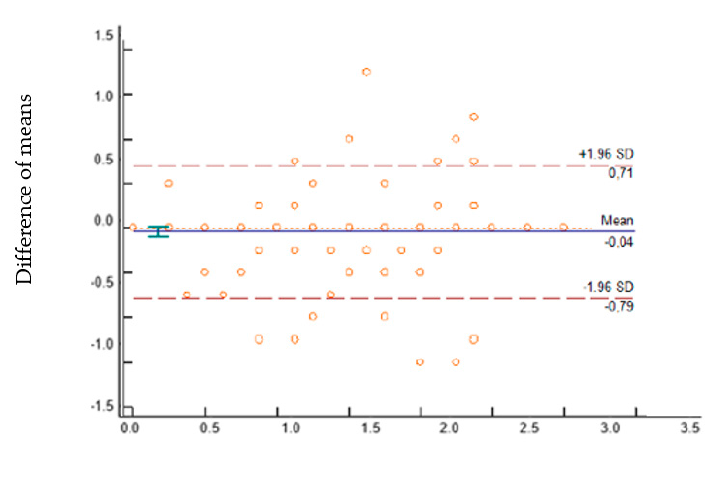
Figure 1. Bland–Altman plot comparing total test and retest scores for individual participants using the Assessment of Stress in Podiatry Students (ASPS).